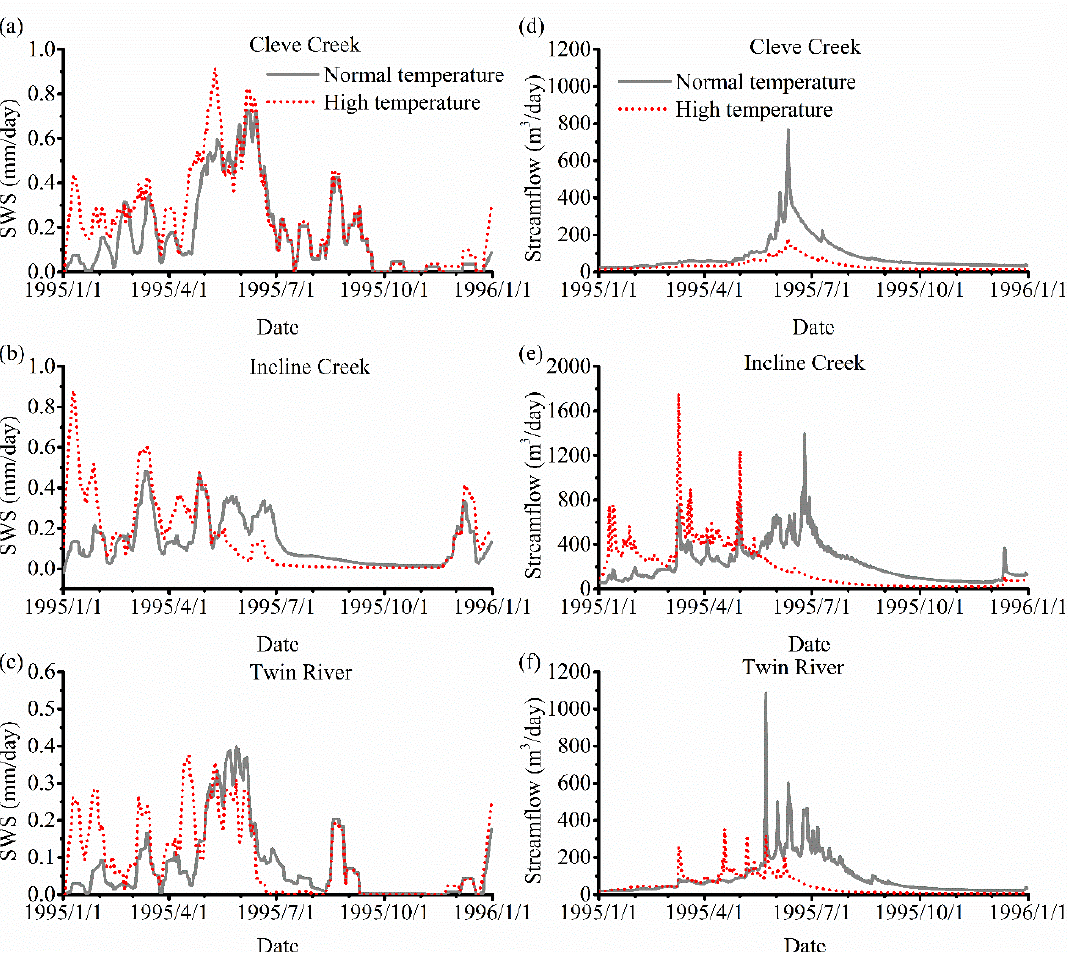
Figure 12. Comparison of Soil Water Storage (SWS) and streamflow under the two different temperature scenarios with vegetation in 1995. The SWS of Cleve Creek, Incline Creek, and Twin River watersheds are shown in ( a – c ), respectively. The streamflow of Cleve Creek, Incline Creek, and Twin River watersheds are shown in ( d – f ), individually.